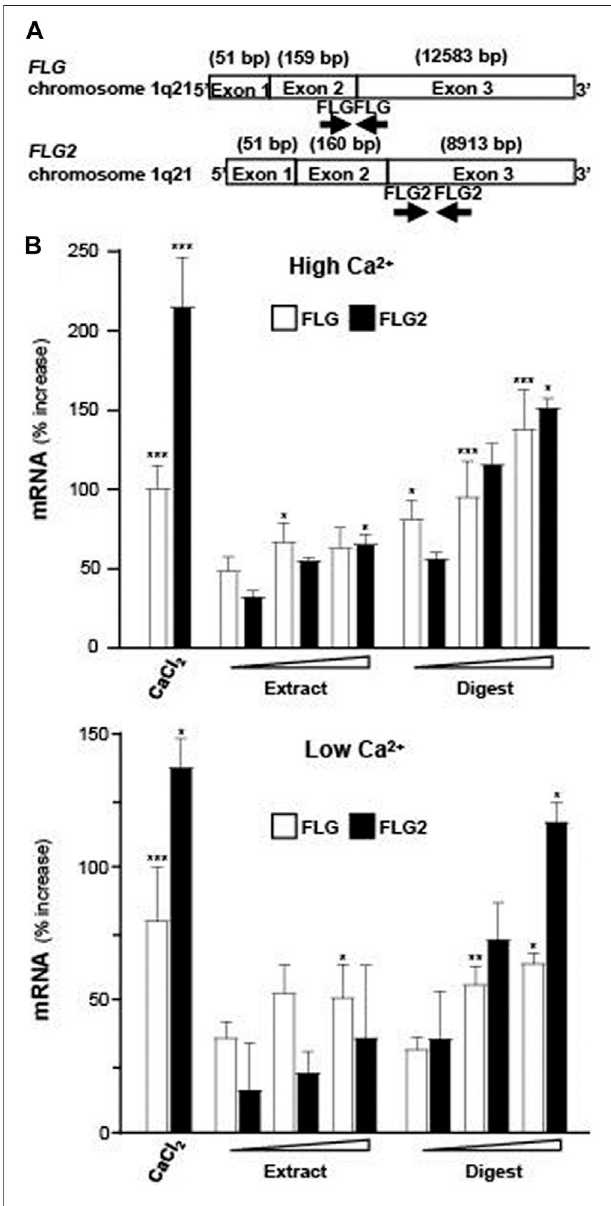
FIGURE2| Expressionsof fi laggrinand fi laggrin-2areevaluatedbyreal- timePCR. (A) Theschematicdiagramsofprimers fl ankingtheexonsofhuman fi laggrin (FLG) and fi laggrin-2 (FLG2) genes on chromosome 1q21 are indicated. (B) Filaggrin and fi laggrin-2 mRNA levels in cultured differentiated (upper panel; 1.8 mM Ca 2+ ) and undifferentiated (lower panel; low Ca 2+ ) keratinocytes after 24-h treatments of EBN extract and digest, in dosesof1,10,100 μ g/mL,asindicated.CaCl 2 at 0.16 mMwasadopted asa positivecontrol.Valuesareexpressed asthepercentage ofincreaseinrelative to normalized basal expression set at 0, in mean ± SEM, n (cid:2) 4. Statistically signi fi cant results are marked with * p < 0.05, ** p < 0.01, and *** p < 0.001 against the